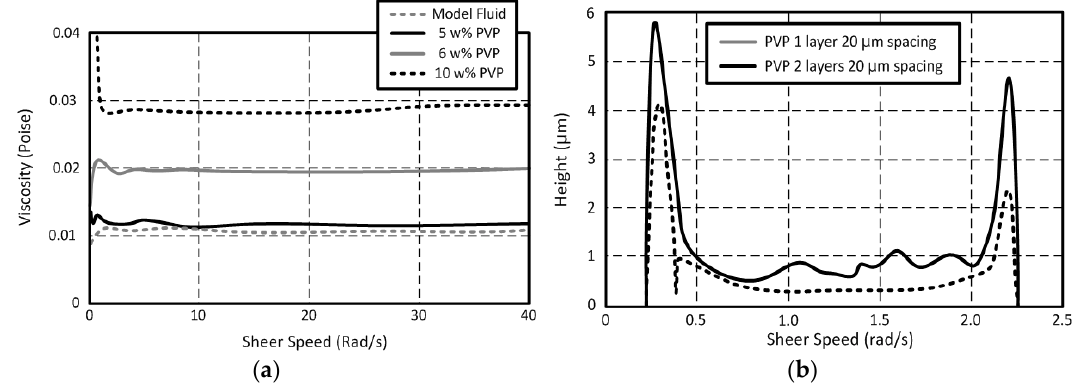
Figure 9. ( a ) Rheometric analysis and ( b ) thickness of the poly (4-vinylphenol) (PVP)-printed